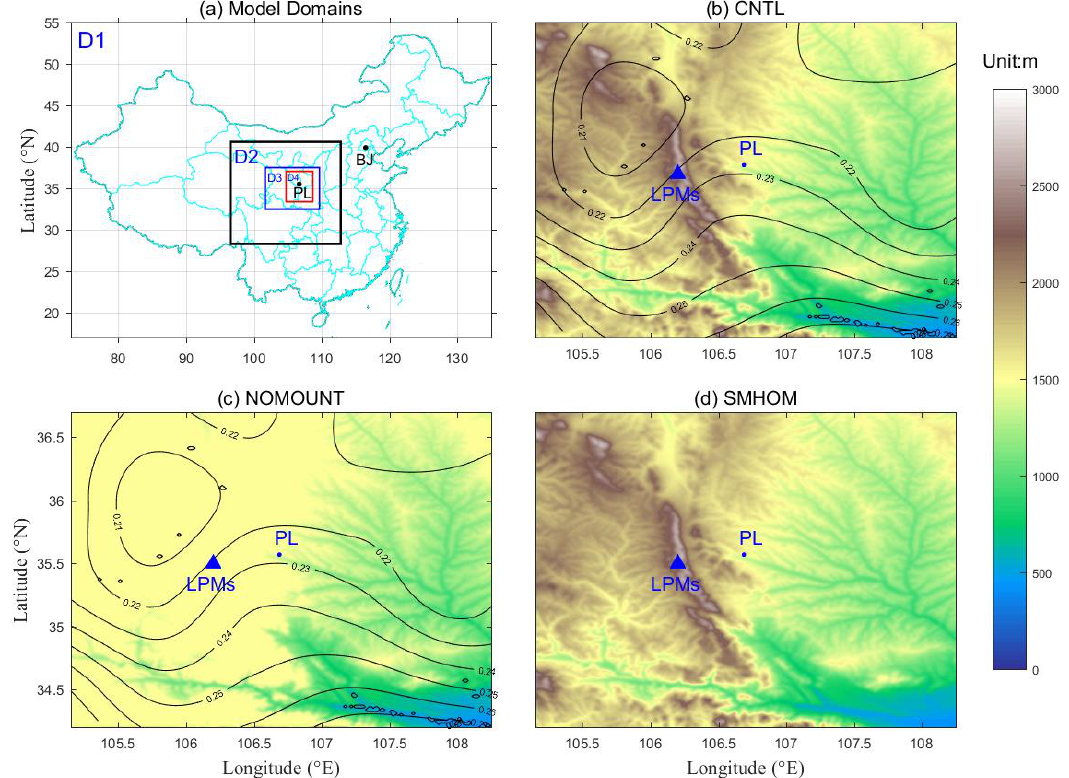
Figure 1. ( a ) Map of model domains and ( b – d ) terrain (shaded, units: m) and soil moisture (black contours, units: m 3 m − 3 ) in the ( b ) control (CNTL), ( c ) terrain removal (NOMOUNT), and ( d ) homogeneous soil moisture (SMHOM) experiment. PL refers to Pingliang Station and Liupan Mountains is indicated as LPMs.